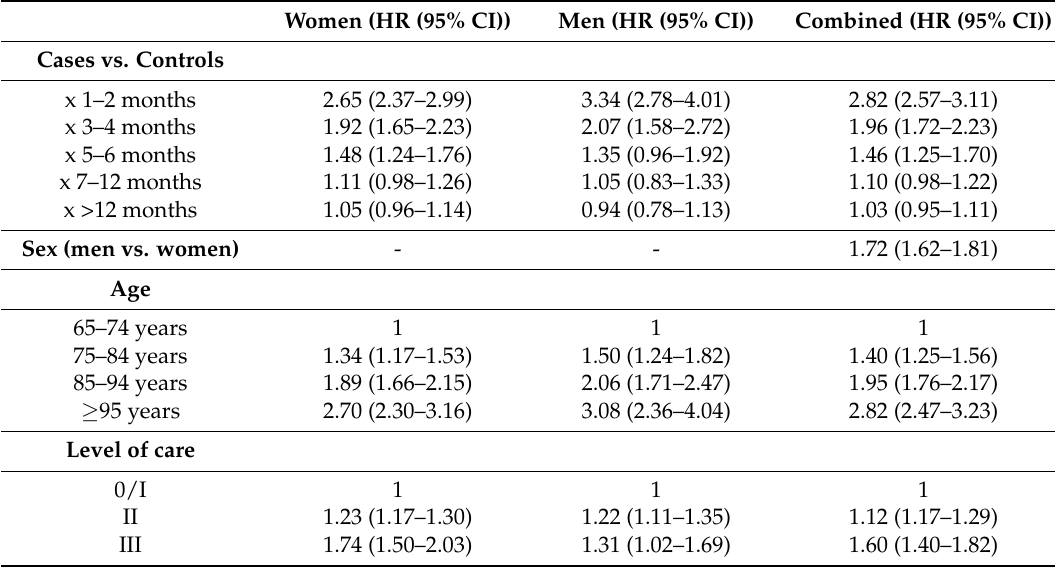
Table 3. Multivariable adjusted mortality risk in the hip fracture group ( n = 8535) and in controls * ( n = 8535) with 95% CI. Women (HR (95% CI)) Men (HR (95% CI)) Combined (HR (95% CI)) Cases vs.